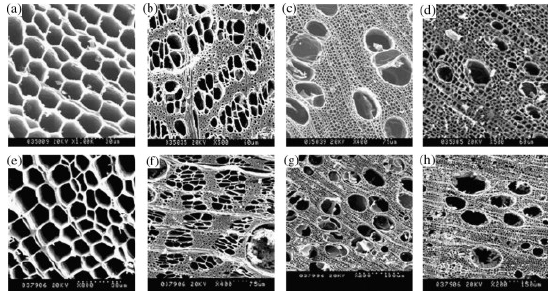
Fig. 2 SEM images of cross section of (a) carbonized Paulownia and (b) Paulownia-templated Fe